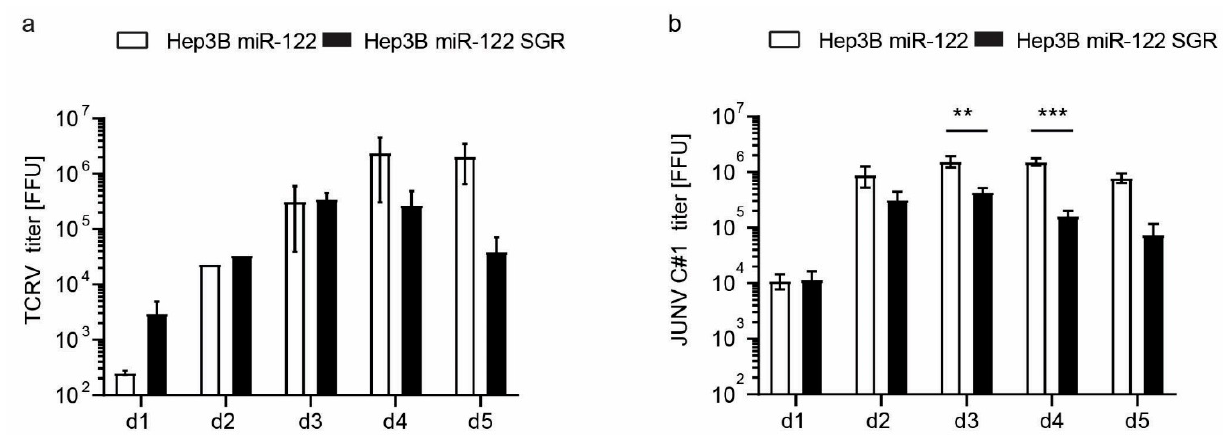
Figure 8. Susceptibility of Hep3B miR-122 and Hep3B miR-122 subgenomic HCV replicon cells to TCRV ( a ) and JUNV Candid#1 (C#1) ( b ). Cells were infected with indicated arenaviruses at an MOI of 0.01 and supernatants were harvested at indicated time points. Viral titers were determined by titration on Vero cells and staining against the nucleoprotein. Results are given as a mean ± SEM of three (JUNV) or two (TCRV) independent experiments (with technical duplicates). Two-way ANOVA, followed by Sidak’s multiple comparison test ** p < 0.01, *** p < 0.001.